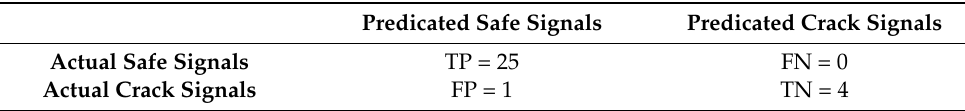
Table 3. Confusion matrix of our proposed